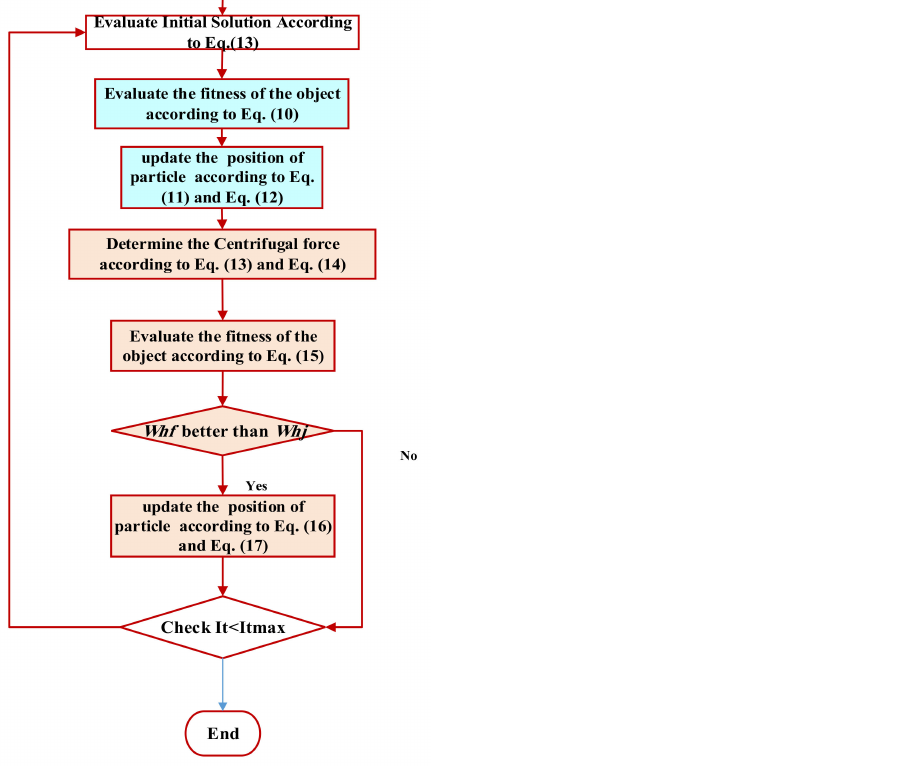
Figure 4. Flowchart of the turbulent flow of water-based optimization algorithm (TFWOA).